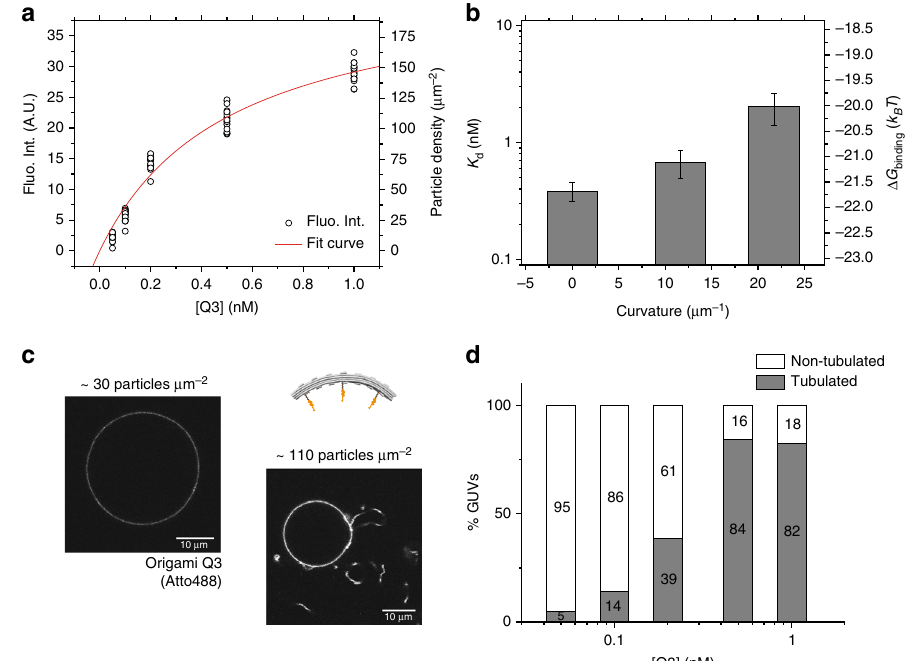
Fig. 4 Tubulation of fl at membranes depends on surface density of membrane-bound curved origami Q. Fluorescence intensities of membrane-bound DNA origami (labeled with 3 × Atto-488 dyes) at equilibrium (incubated overnight) were extracted using image analysis and represented as a function of total bulk concentration ( a ; here depicted for one independent set of measurements with Q3). Representative confocal images at the equatorial plane for membrane-bound Q3 nanostructures are depicted in c . Membrane binding of the DNA nanostructures was quantitatively investigated by fi tting the data to a Langmuir isotherm (equation 1), enabling the determination of apparent membrane dissociation constants K d ( ± s.d.): L3 ( n total = 288 GUVs; n = 131 – 157 GUVs per fi t, 2 repeats), Q3 ( n total = 277 GUVs; n = 83 – 100 GUVs per fi t, 3 repeats) and H3 ( n total = 106 GUVs; n = 48 – 58 GUVs per fi t, 2 repeats) ( b ). Δ G Δ G = RT ln K fi ciencies of membrane tubulation ( d ), high yields ( > 80%) were retrieved for Q3 bulk binding was calculated via d . Regarding ef concentrations ≥ 0.5 nM, or, upon conversion to surface densities, for ≥ 90 membrane-bound DNA origami particles per μ m 2 (as illustrated in c ). Scale bars: 10 µ m. Error bars in b correspond to